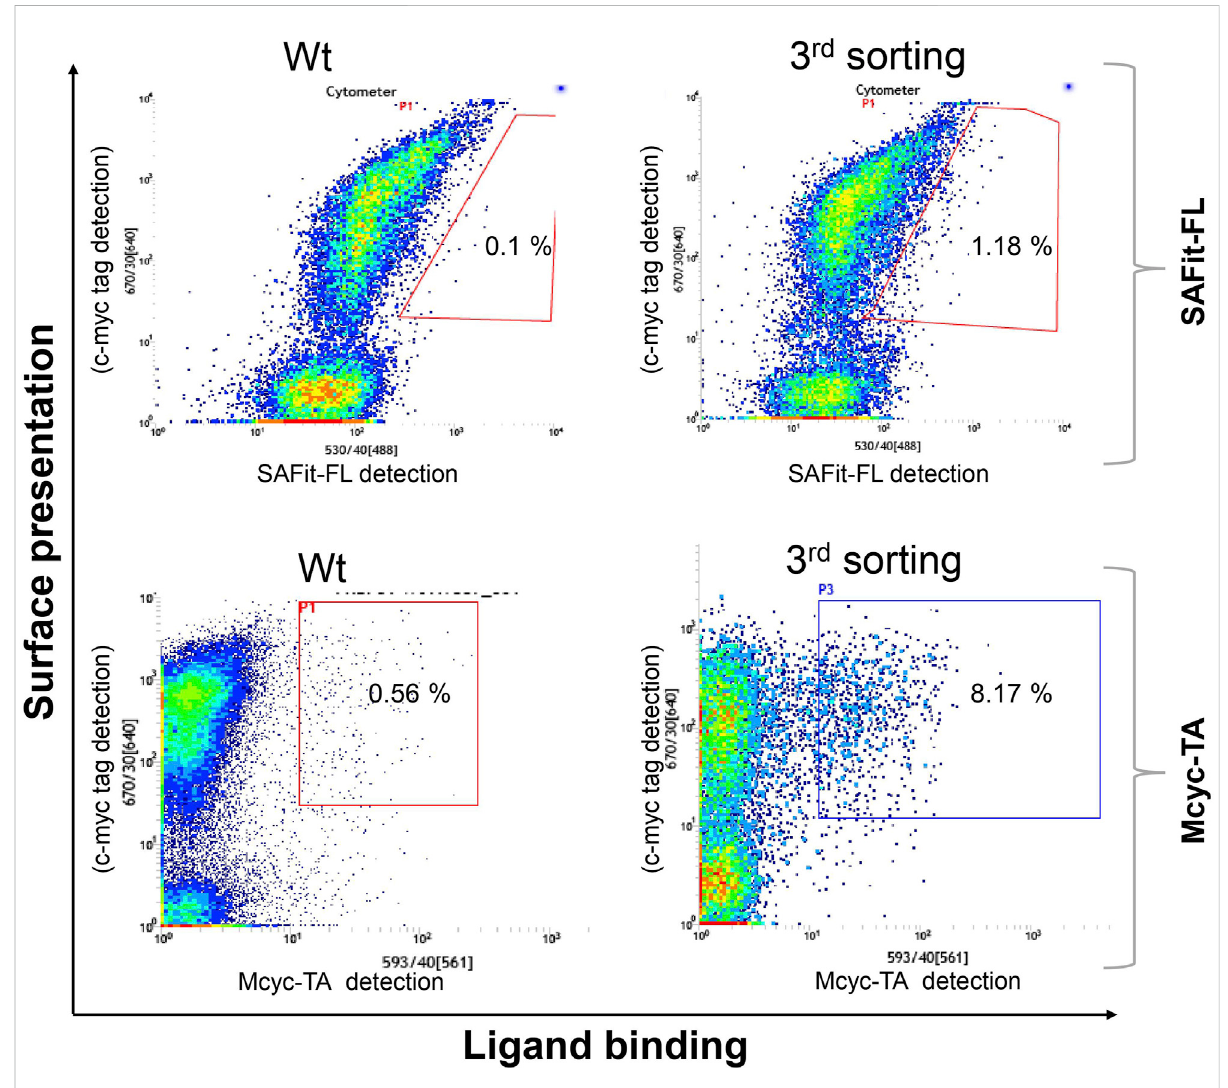
FIGURE 3 Random mutagenesis YSD library screening and sorting. Cells showing both surface presentation (c-myc tag detection) and ligand binding signal(SAFit-FL (out/in) orMcyc-TA (out/out) )weresorted toenrichthepopulationofligandbindervariantsafter randommutagenesisoftheFK1coding sequence. Sorting gate wassetto capture approximately 1%of thetracer binding populationand used for subsequent sortingroundsor single clone